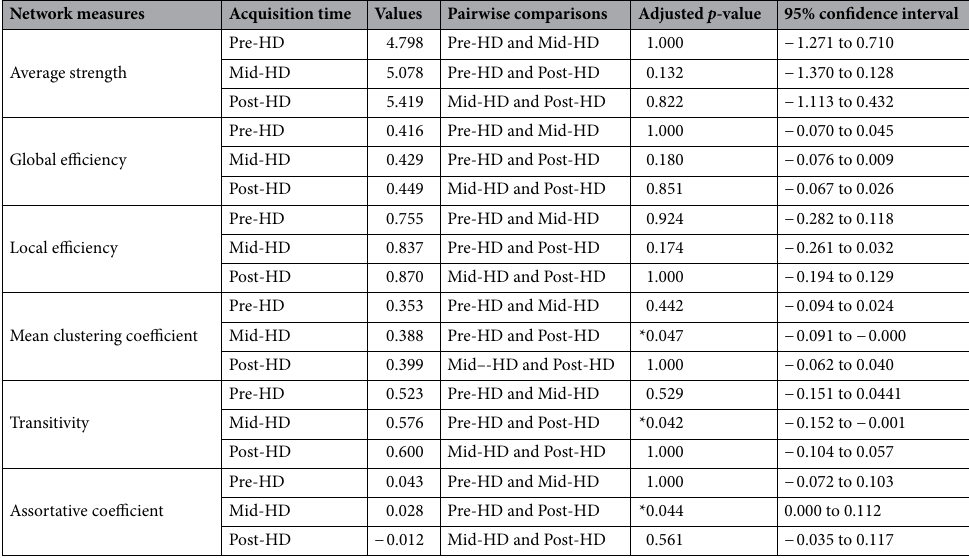
Table 2. Changes in the functional brain connectivity measures based on hemodialysis in patients with ESRD. HD hemodialysis. *Statistical